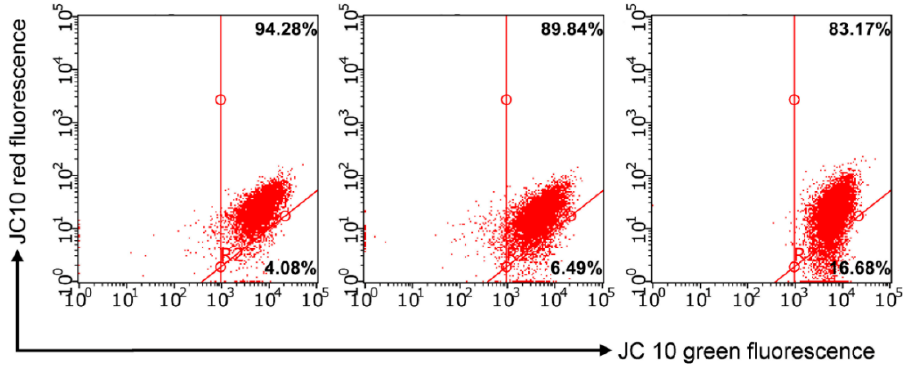
Figure 11. Effects on the mitochondrial membrane potential by 7 in M-HeLa cells. 1—at concentration IC 50 /2 (6 µ M); 2—at concentration IC 50 (12 µ M).